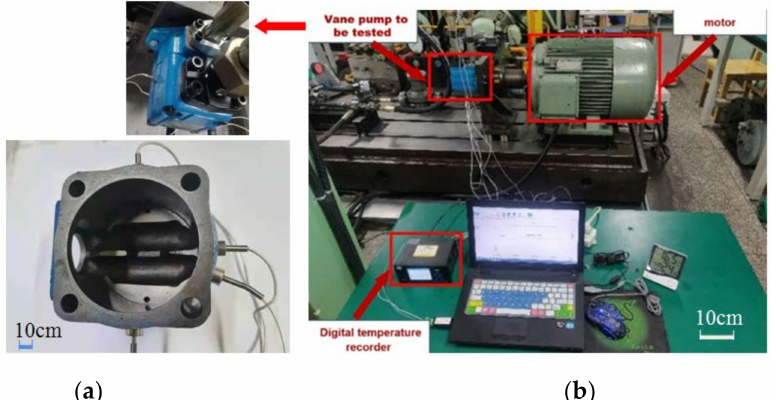
Figure 16. The pump shell and Test site diagram. ( a ) The pump shell with temperature sensors; ( b ) Test site diagram.